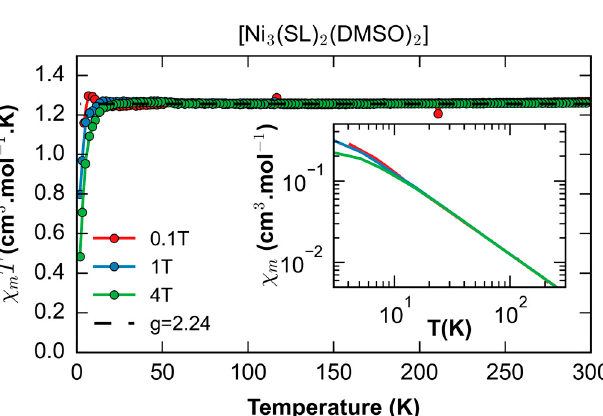
Figure 3. Temperature dependence of the magnetic susceptibility for Ni 3 L 2 . The inset is the temperature dependence of the susceptibility in log scale showing the expected Curie behaviour for any field at T > 10 K.